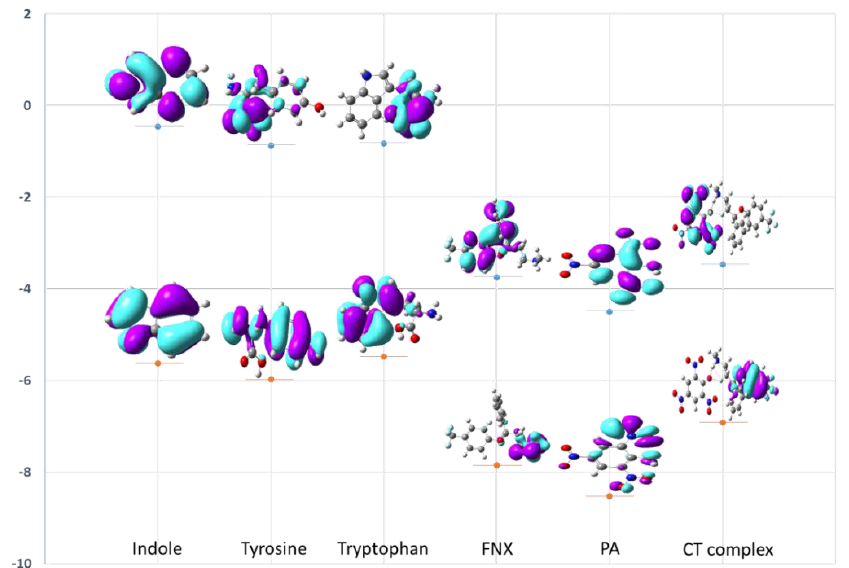
Figure 19. HOMO and LUMO energy levels of the molecular orbitals for indole, tyrosine, tryptophan, FXN, PA, and [(FXN)(PA)]. Table 4. HOMO and LUMO energies calculated for tyrosine, tryptophan, FXN, PA, and